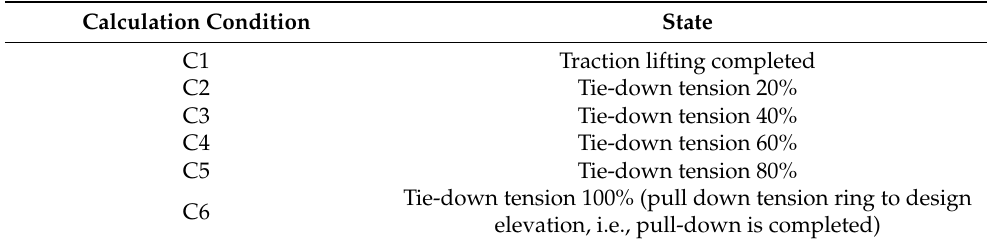
Table 15. Calculation conditions during synchronous proportional tension